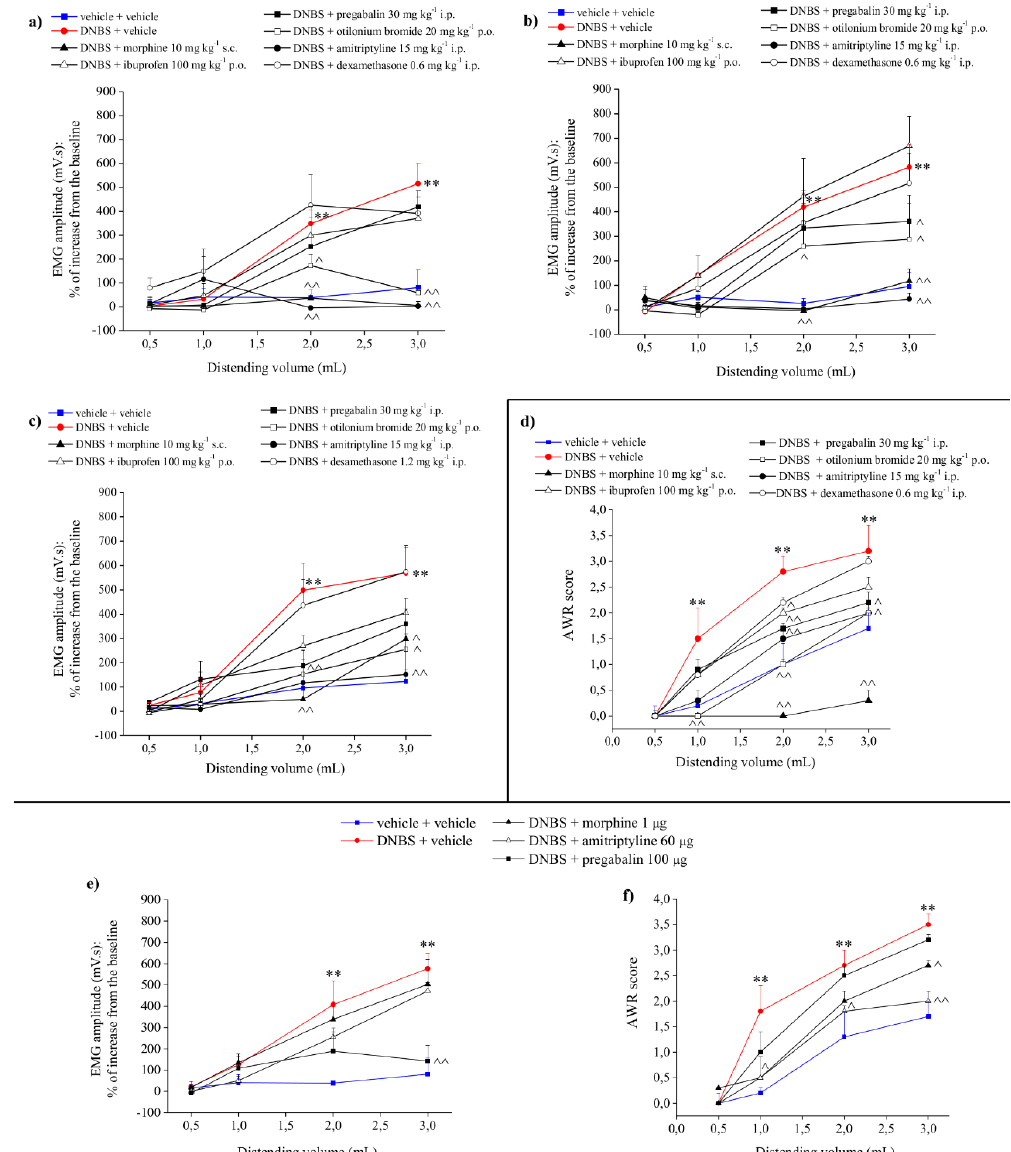
Figure 3. Effects of reference drugs on visceral hypersensitivity; comparison between systemic and intrathecal administration. Systemic effects: ( a – c ) viscero-motor response to colo-rectal distension.